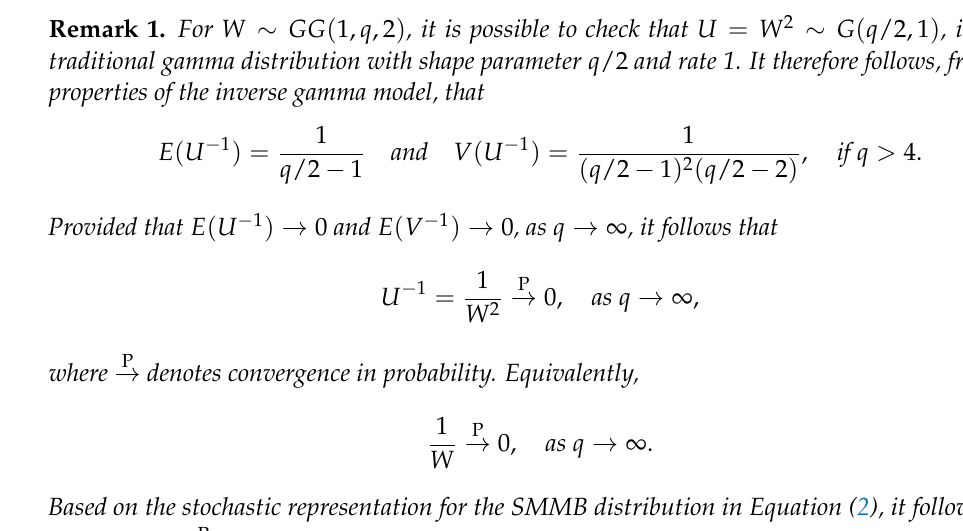
Figure 1. ( Left panel ): pdf for SMMB ( β = 1, q ) model. ( Right panel ): cdf for SMMB ( β = 1, q ) model. In both cases, different values for q were